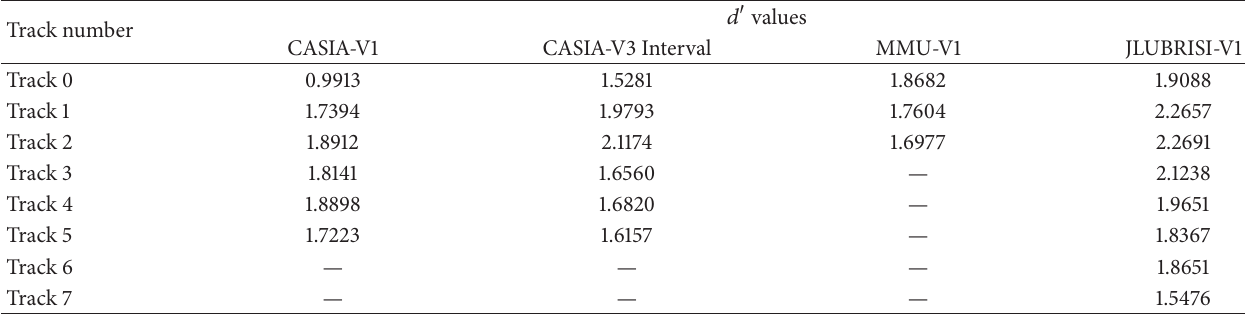
Figure 10: Distance distributions of the intra-class and inter-class patterns for the four iris image databases without fusion. (a) CAISA-V1, (b) CASIA-V3 Interval, (c) MMU-V1 and (d) JLUBRIRIS-V1 iris image databases. Table 5: 𝑑 󸀠 values of different